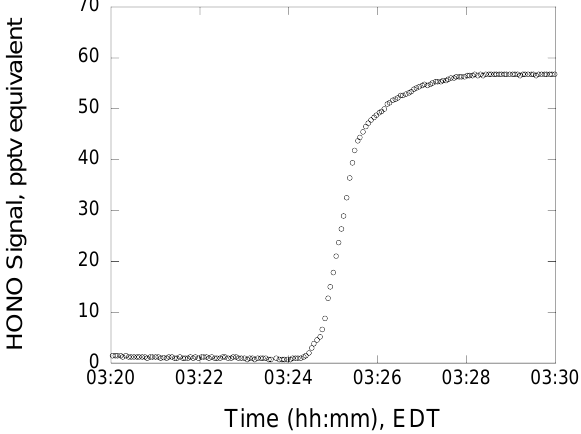
Fig. 3. An excerpt of 10-min HONO raw data during the transition from the “zero-HONO” baseline to ambient HONO measurement, 25 July 2008. The time in the x-axis is Eastern Daytime-saving Time (EDT, GMT – 04:00).